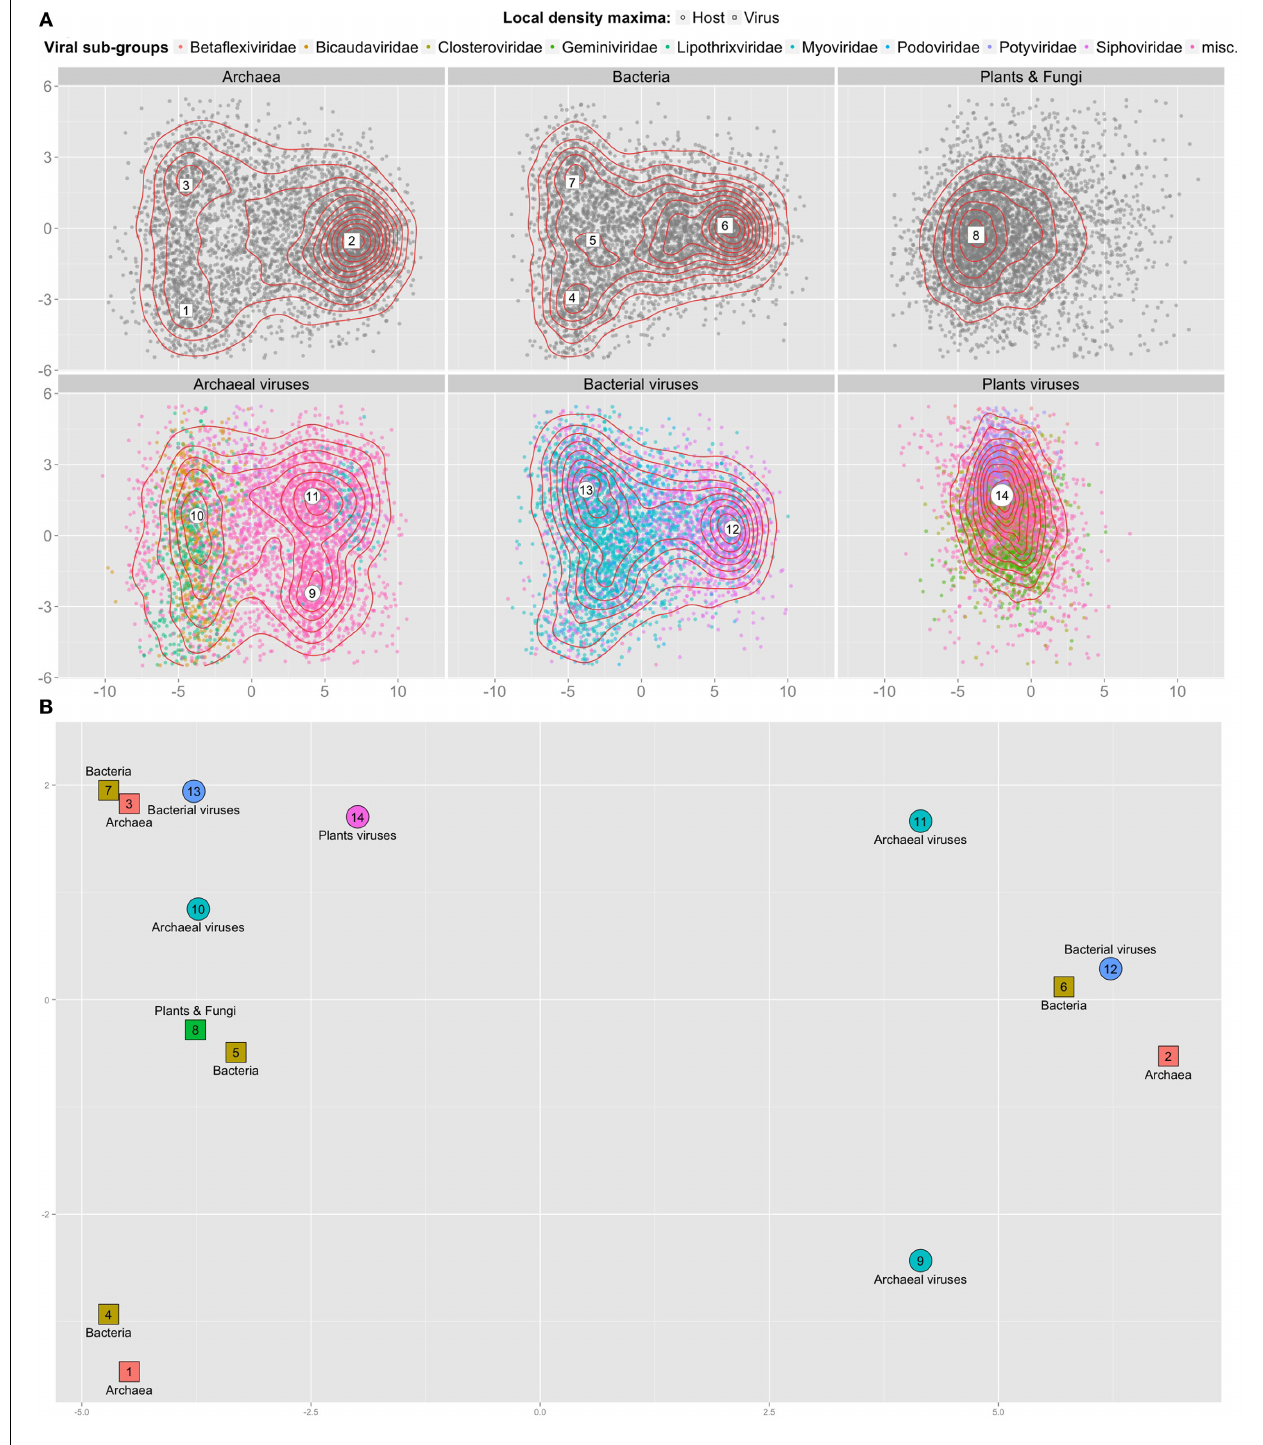
FIGURE 2 | 2D projection of 3-mer frequencies for cellular and viral contigs. (A) Top two dimensions from the PCA reduction of 28,134 contigs (points) of average length 500 nt represented as frequency vectors of 3-mers; sampled equally from genomes originating from 3 top levels cellular domains (top row) and from 3 viral types known to infect them (bottom row). Dimension 1 (x-axis) accounts for 30% of the variance, dimension 2 (y-axis)